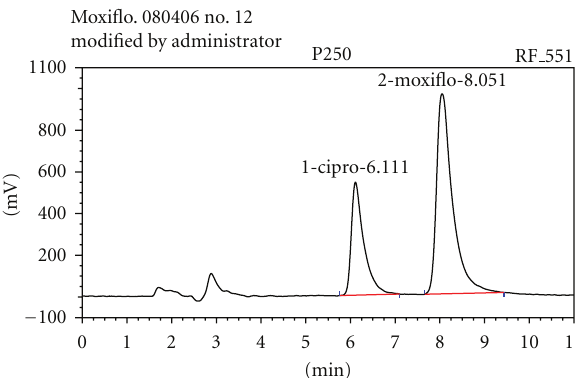
Figure 2: Chromatogram of moxifloxacin (retention time = 8.0 min) and the internal standard ciprofloxacin (retention time = 6.0min) in plasma (concentration = 250 µ